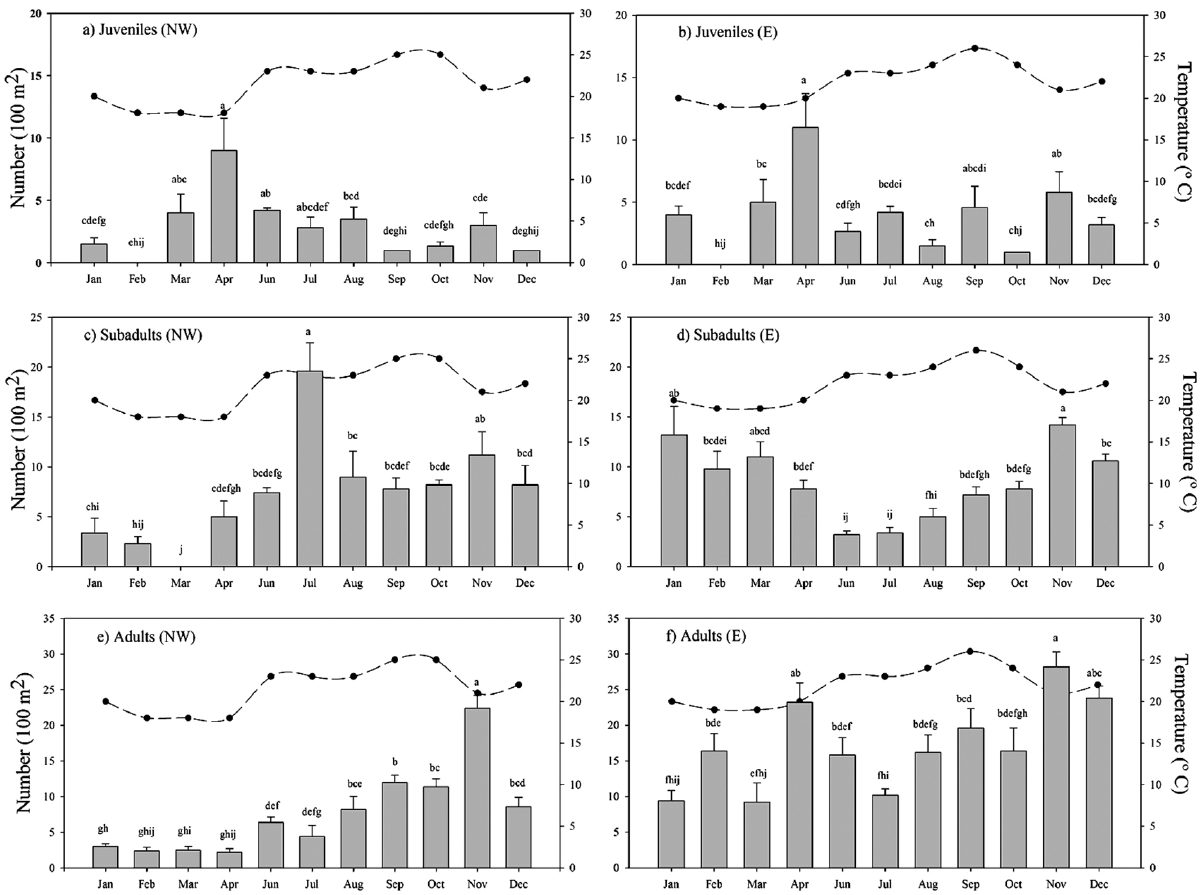
Fig. 8. – Mean (±SE) abundances of individuals (ind/100 m 2 ), including juveniles (a, b), sub-adults (c, d) and adults (e, f). Water temperature at the bottom (full circles) throughout the study is also